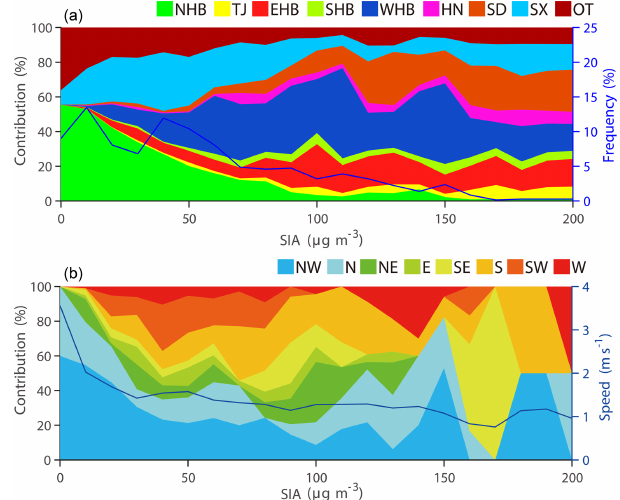
Figure 8. (a) Relative contribution of regionally transported SIA under different pollution levels in Beijing during the whole study period. (b) Variation of wind direction under different pollution lev- els in Beijing during the whole study